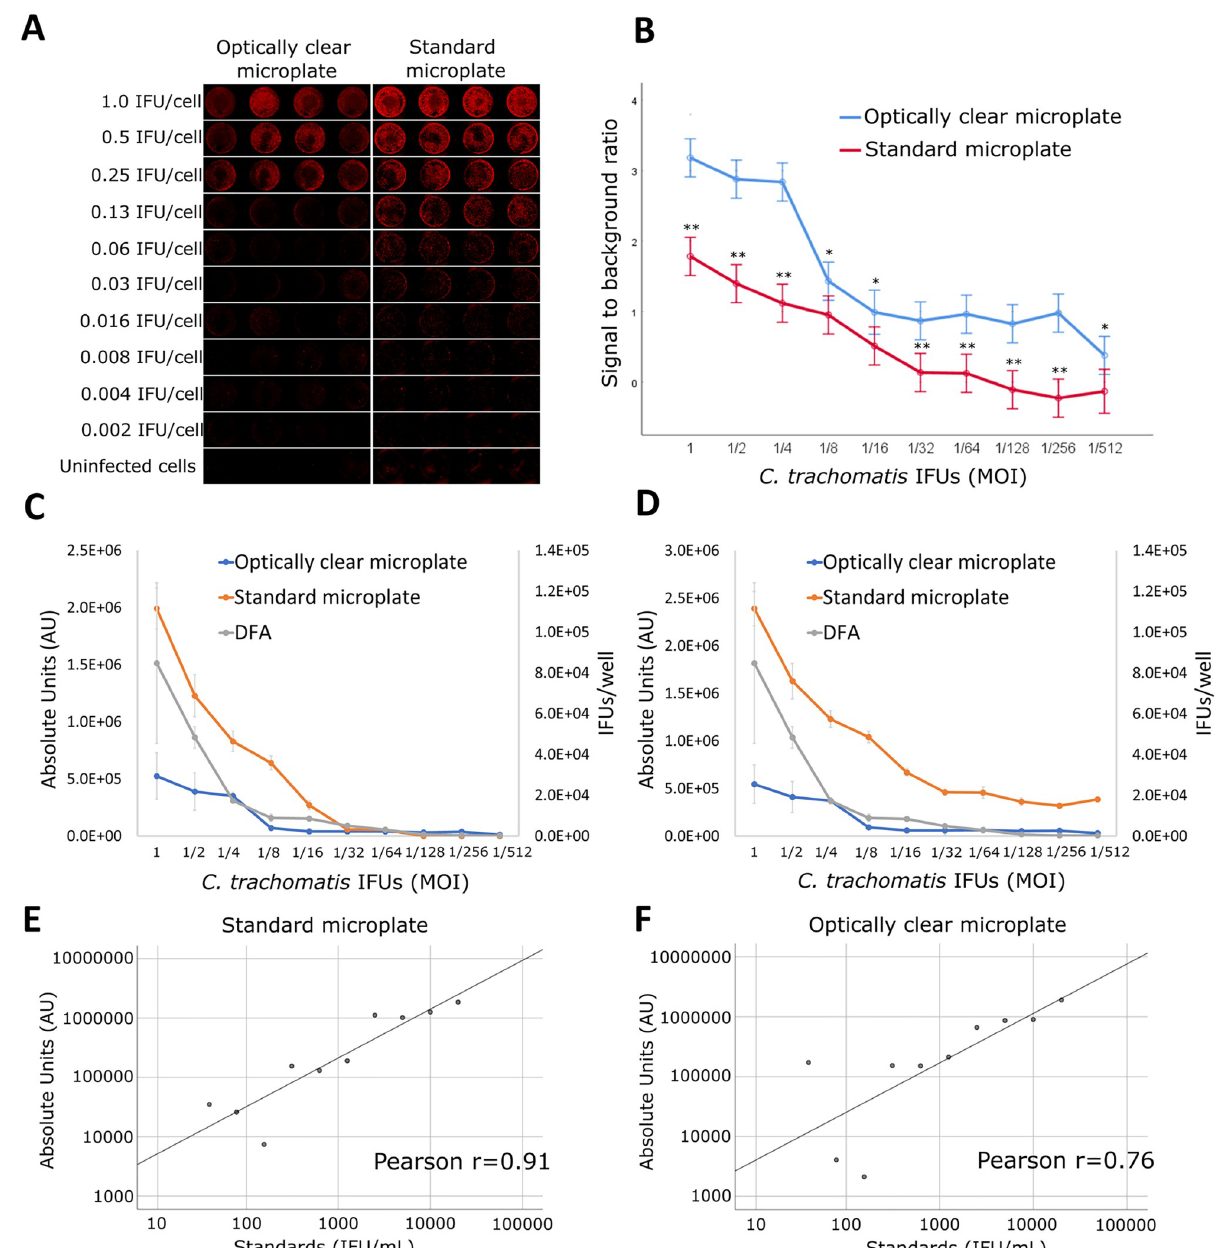
Fig 1. Standard curves of C . trachomatis IFUs via ICW assay in optically clear bottom and standard microplates, related to the enumeration of chlamydial IFUs by DFA assay. ICW assay: confluent McCoy cell monolayers, grown on either 96-well standard polystyrene or optically clear bottom cell culture microplates, were infected with two-fold serial dilutions of C. trachomatis EB suspension, from MOI of 1.0 to 1/2 9 IFUs/cell. After 36 hours post infection, infected cell monolayers were fixed in 4% PFA, permeabilized by 0.1% triton x-100 in PBS, stained and scanned via Odyssey CLx as described in Materials and Methods. DFA: confluent McCoy cell monolayers, grown on coverslips in 24-well cell culture microplates, were infected as above described. After 36 hours post infection, infected cell monolayers were fixed in 96% ice cold methanol, stained and visualized via fluorescence microscopy (400X magnification) as described in Materials and Methods. (A) Representative infrared scan images of Chlamydia-infected cells on standard polystyrene cell-culture or optically clear bottom microplates from at least three independent experiments; (B) Signal to noise ratio of Chlamydia-infected cells in either standard polystyrene cell-culture or optically clear bottom microplates; Standard curves of C . trachomatis IFUs via ICW in optically clear bottom and standard microplates, calculated from near-infrared absorbance data with background (C) or no-background (D) subtraction, related to the enumeration of chlamydial IFU via DFA; Linear regression models of standard curves by the ICW assay after log- transformation on (E) standard polystyrene cell-culture microplates or (F) optically clear bottom microplates. �� , p < 0.001; � , p < 0.05.